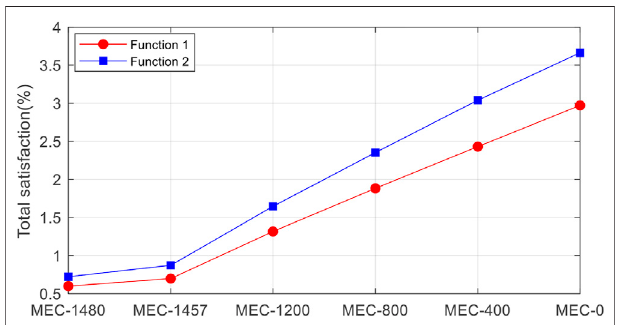
FIGURE 11 | Impacts of satisfaction